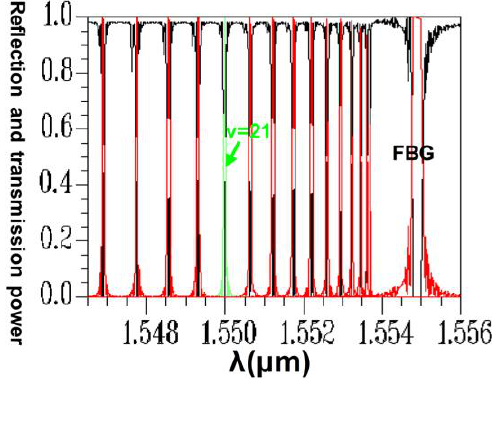
Figure 26. Plot between the FBG period and the reflection (or transmission) power for the total coupling from HE to a counterpropagating cladding mode ( ν = 21). The black line 11 expresses the core mode and cladding modes transmission power. The red line expresses the core mode and cladding modes reflection